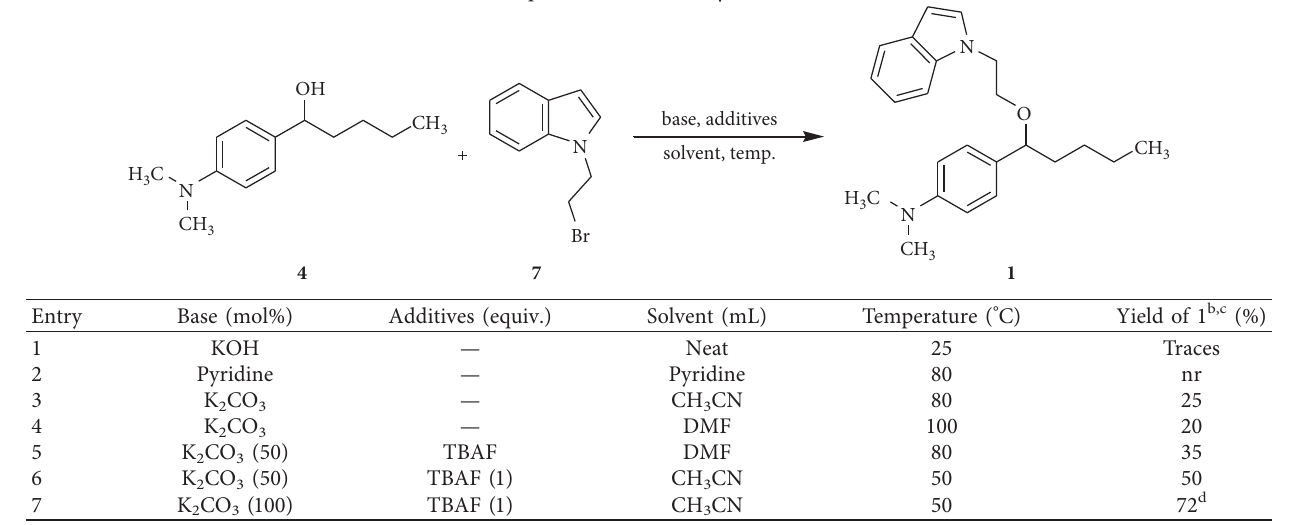
Table 1: Optimization of O-alkylation reaction a .